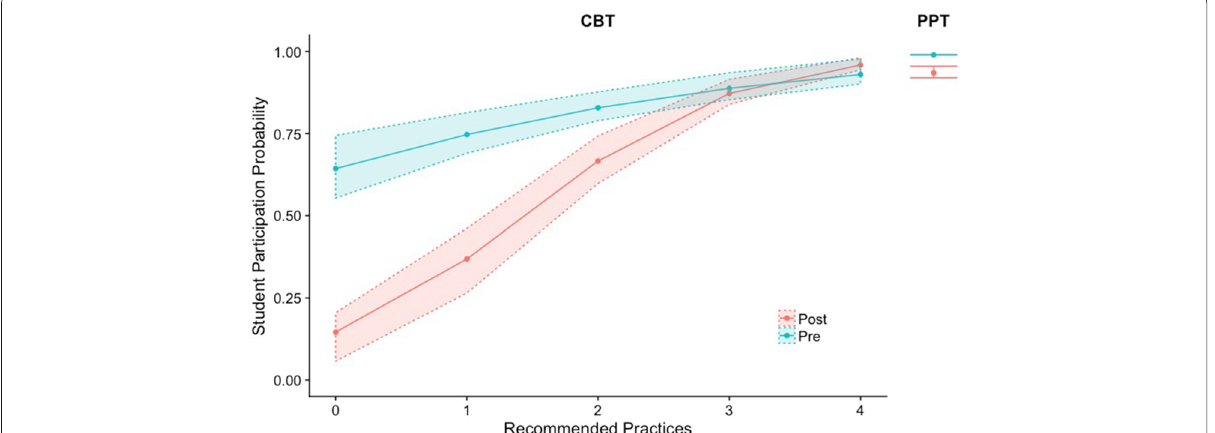
Fig. 3 Student predicted participation rates (+/ − 1 standard error) by assessment condition and use of CBT recommended practices from model 2. When instructors used all four recommended practices, participation rates on CBT and PPT were